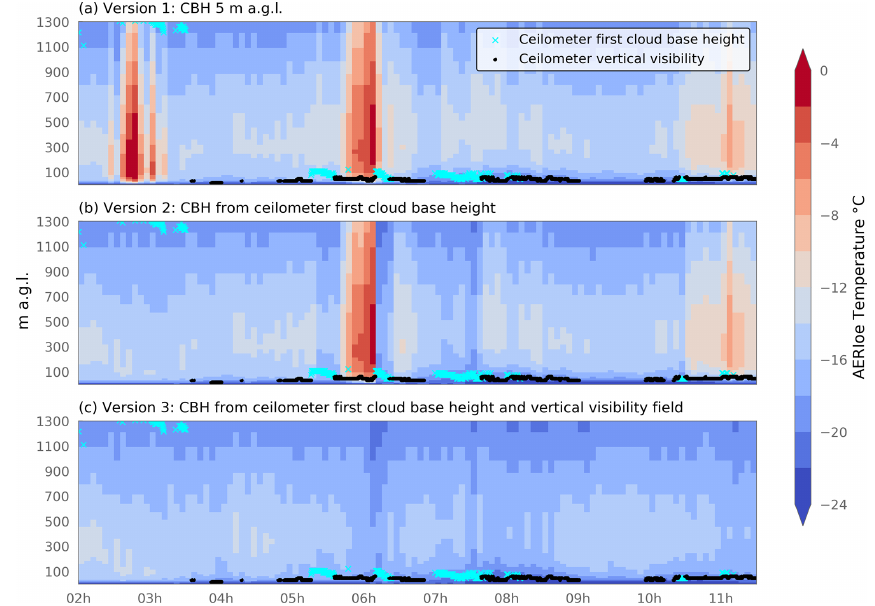
Figure 3. Temperature profiles during the 5 September case study from three iterations of the AERIoe retrieval using different CBH assump- tions. The ceilometer first cloud base height field is overlaid as cyan crosses, and the vertical visibility field is overlaid as black circles. (a) Assumed CBH was 5ma.g.l. any time LWP > 0; (b) assumed CBH was set to the ceilometer first cloud base height if the ceilometer detected a cloud within the 10min centred on the retrieval time, otherwise 5ma.g.l.; (c) as in (b) except if the ceilometer reported “obscured” the CBH was set equal to the ceilometer maximum vertical visibility